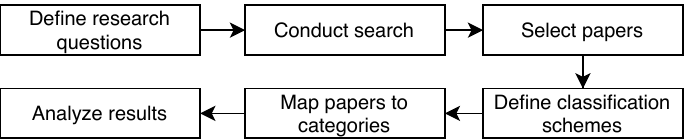
Figure 2. Workflow of the systematic mapping study consists of six